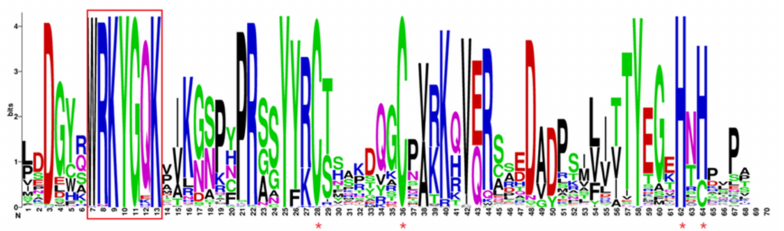
Figure 3. WRKY gene family conserved domain, WRKYGQK conserved domain in the red box, red asterisk refers to zinc finger